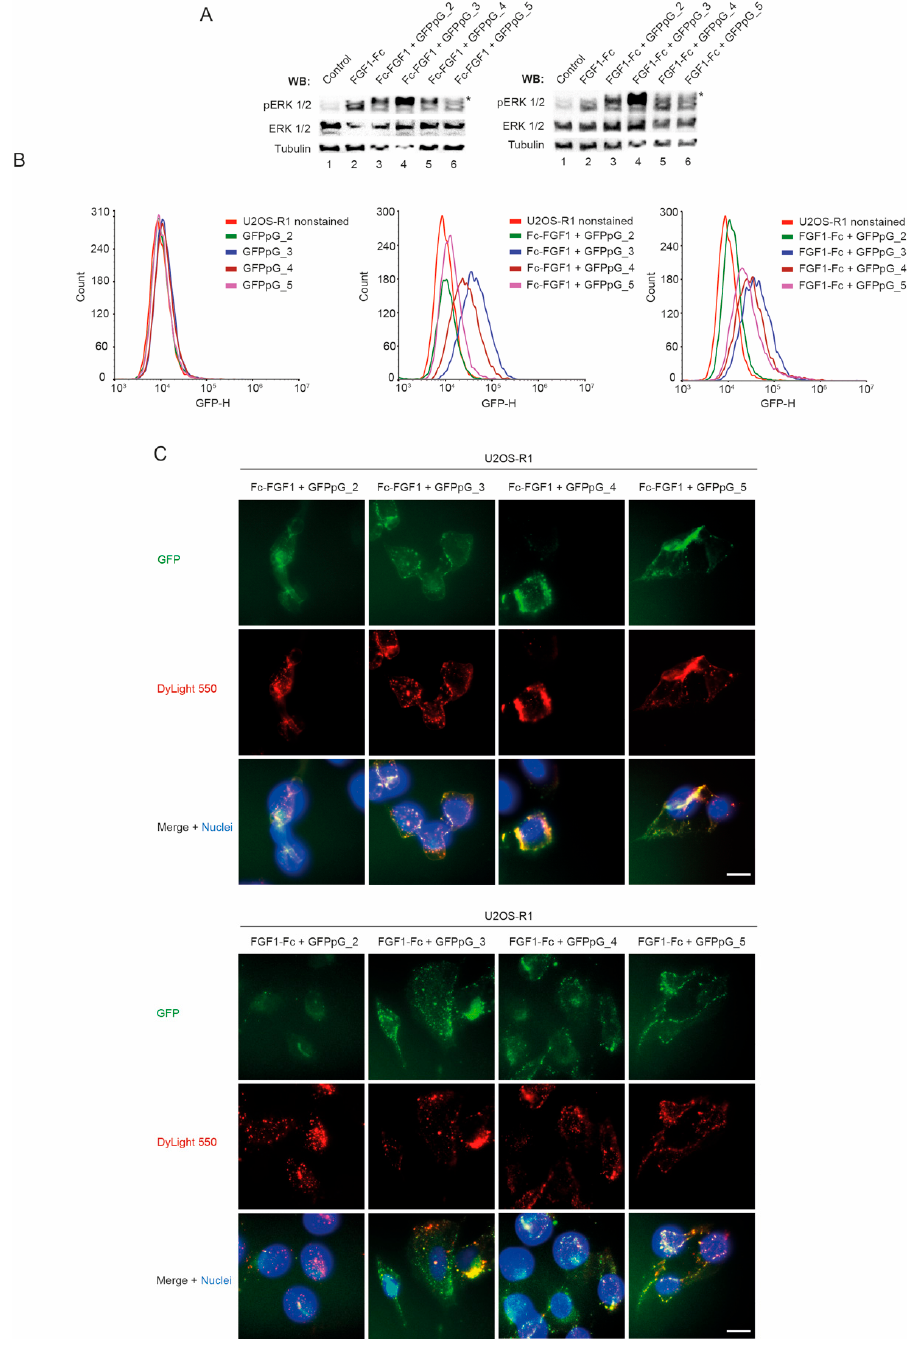
Figure 6. Biological activity of FGF1 and GFPpG complexes. ( A ) Serum-starved NIH3T3 cells were incubated for 15 min with Fc-FGF1 or FGF1-Fc and each of GFPpG variant. Mix of proteins were added in the presence of heparin (10 U/mL). Cells were lysed and activation of receptor-downstream ERK1/2 signaling was assessed with Western blotting (with antibodies recognizing phosphorylated ERK1/2 (pERK1/2)). The level of tubulin served as a loading control. ( B ) Efficiency of FGF1 and GFPpG complexes internalization analyzed by flow cytometry. Serum-starved U2OS-R1 cells were treated with fluorescent GFPpG variants and Fc-FGF1 or FGF1-Fc. After 20 min of incubation on ice, cells were transferred to 37 ◦ C for 30 min, and then subsequently analyzed by NovoCyte 2060R Flow Cytometer. ( C ) FGFR1-mediated internalization of FGF1 and GFPpG multivalent complexes. U2OS-R1 cells were incubated with each of GFPpG variant (green) and DyLight 550 NHS Ester labeled Fc-FGF1 or FGF1-Fc (red) for 20 min on ice, and then for 45 min at 37 ◦ C. Nuclei were stained with NucBlue Live. Cells were fixed and visualized using wide-field fluorescence microscope. The scale bar represents 20 µ m. *—nonspecific signal from